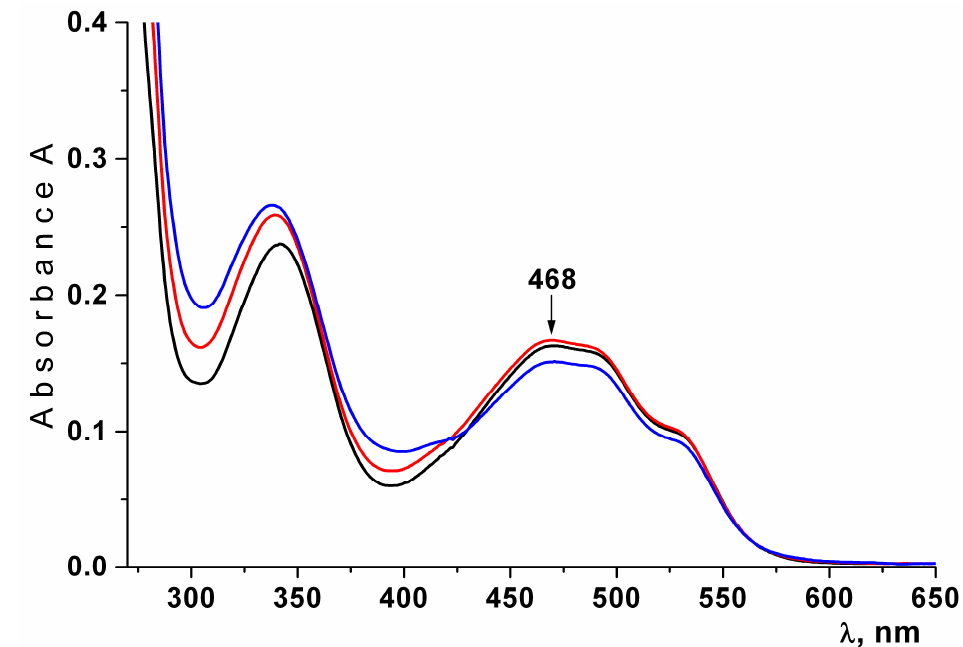
Figure 4. Absorption spectra of the Ech extracted with butanol from freshly prepared liposomes (black lines); from freshly prepared lyophilized dried liposomes (red line); from lyophilized dried liposomes after 30 days of storage at 4 after 30 days of being kept at 4 °C (blue line). The SEM analysis revealed the formation of a population of heterogeneous vesicles ranging from 419.5 ± 12.0 to 494.8 ± 4.0 nm in size (Supplementary Figure